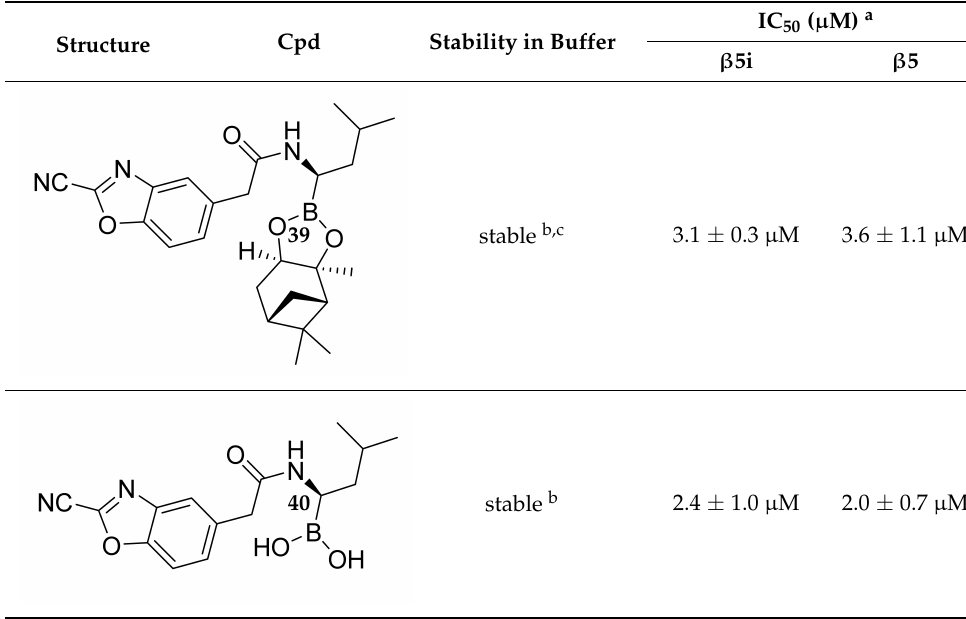
Table 5. Inhibitory potencies of benzoxazole-2-carbonitriles combined with boronic acid derivatives against the β 5i subunit of human iCP and the β 5 subunit of human cCP. The RA (for β 5i and β 5) values were determined at 10 µ M of the compounds and 30 min pre-incubation.